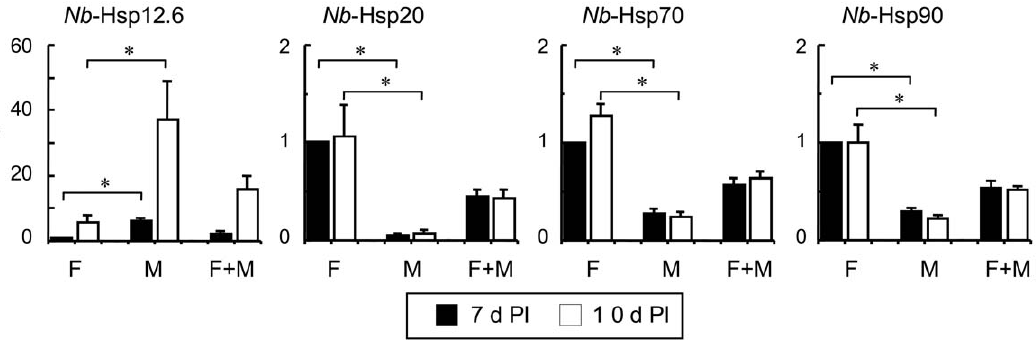
Figure 3. Gender differences in the Hsp gene expression levels of N.brasiliensis adult worms. F, females; M, males; F + M, a mixture of the same amounts of cDNA from males and females. The levels in the ‘F’ at 7 days PI are expressed as 1.0. Data shown are mean and SD of worms recovered from 4 SD rats. * P , 0.05.